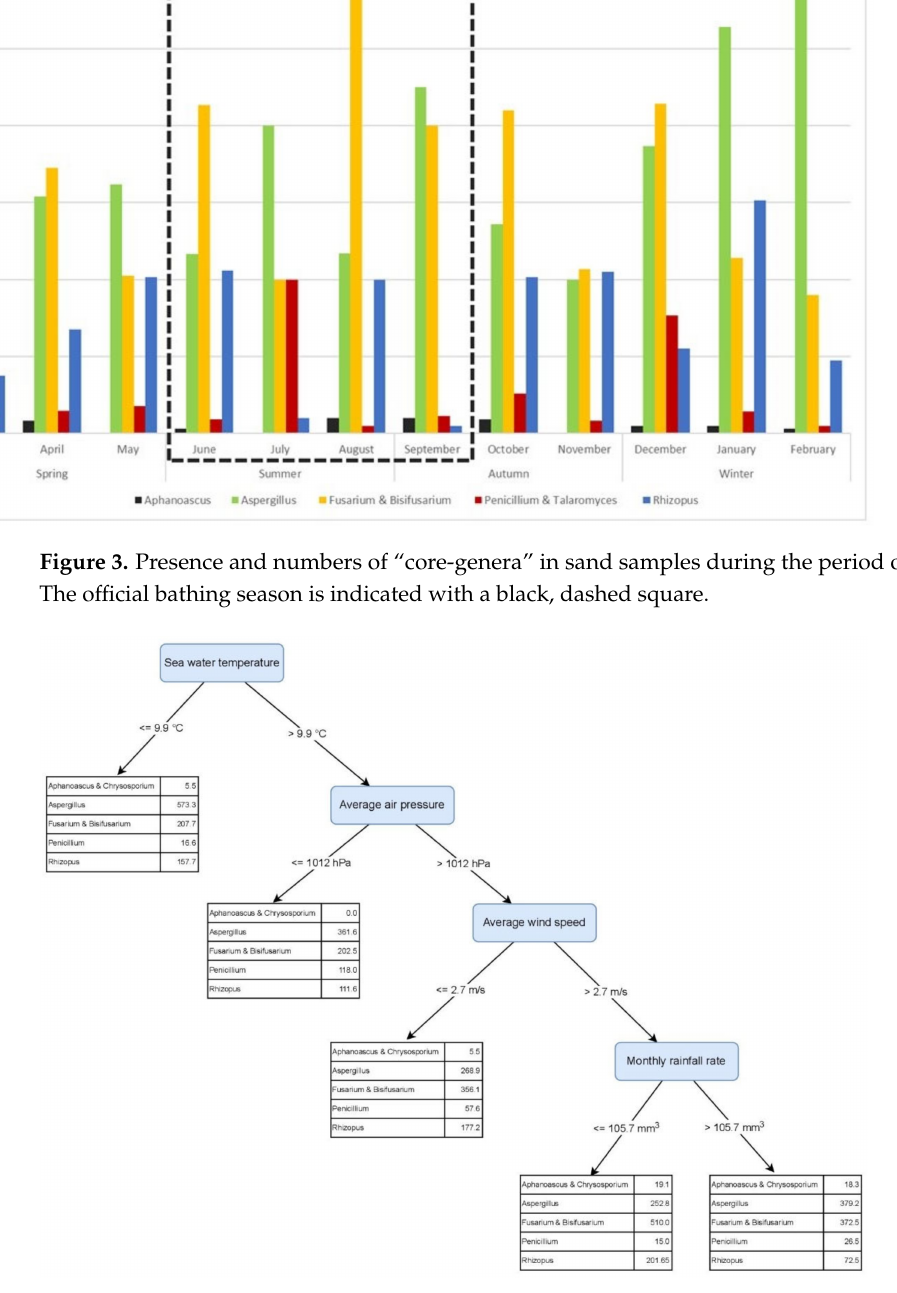
Figure 4. Predictive Clustering Tree (PCT) for multi-target regression (MTR), predicting the abun- dance of the core-genera, isolated from beach sand and seawater. The model predicts the highest abundances for Aspergillus and Fusarium & Bisifusarium . Particularly high abundance of Aspergillus is predicted when sea water temperature is below or equal to 9.9 ◦ C (leftmost leaf), while high abundance of Fusarium & Bisifusarium is predicted when sea water is warmer (>9.9 ◦ C), air pressure is high (>1012 hPa), average wind speeds are higher than 2.7 m/s and monthly rainfall rate is below or equal to 105.7 mm 3 (rightmost leaf). The genus Aphanoascus is always predicted in lowest